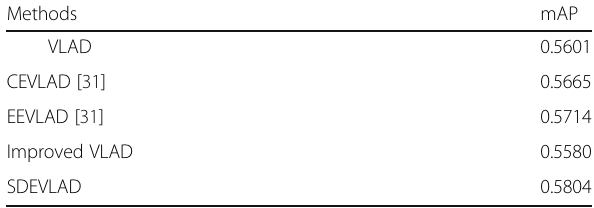
Table 5 Results of image classification task